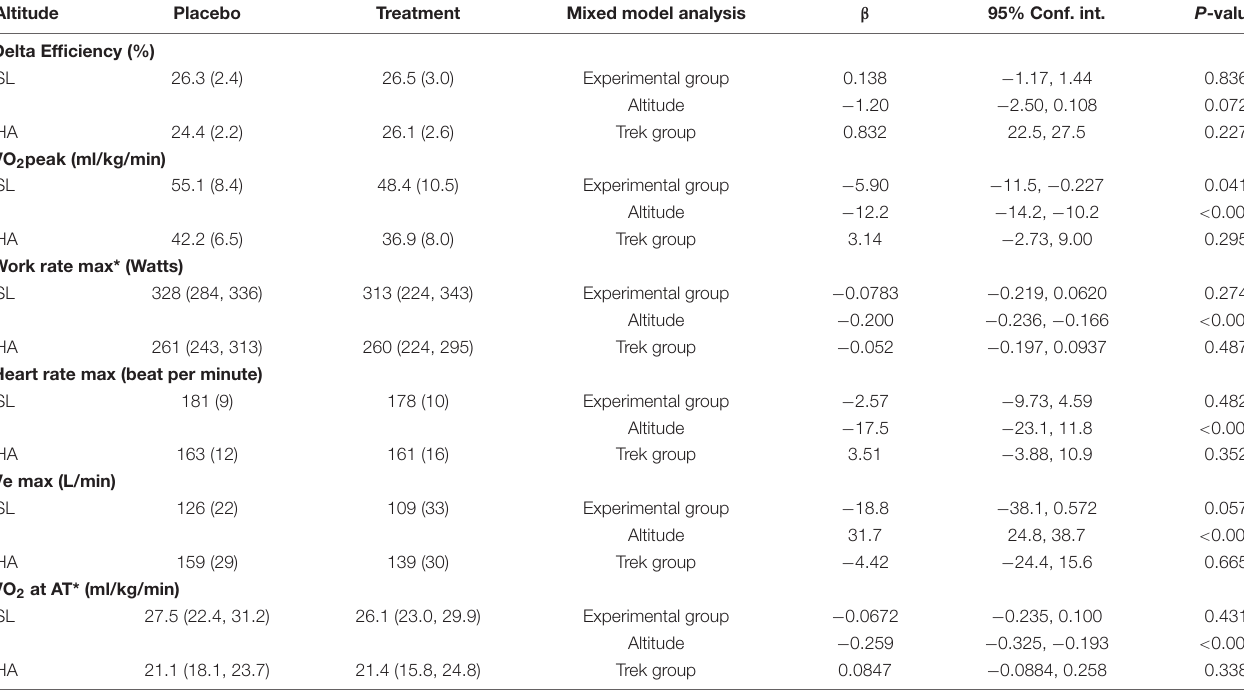
TABLE 1 | Descriptive results and regression coefficients for exercise physiological variables according to linear mixed modeling.